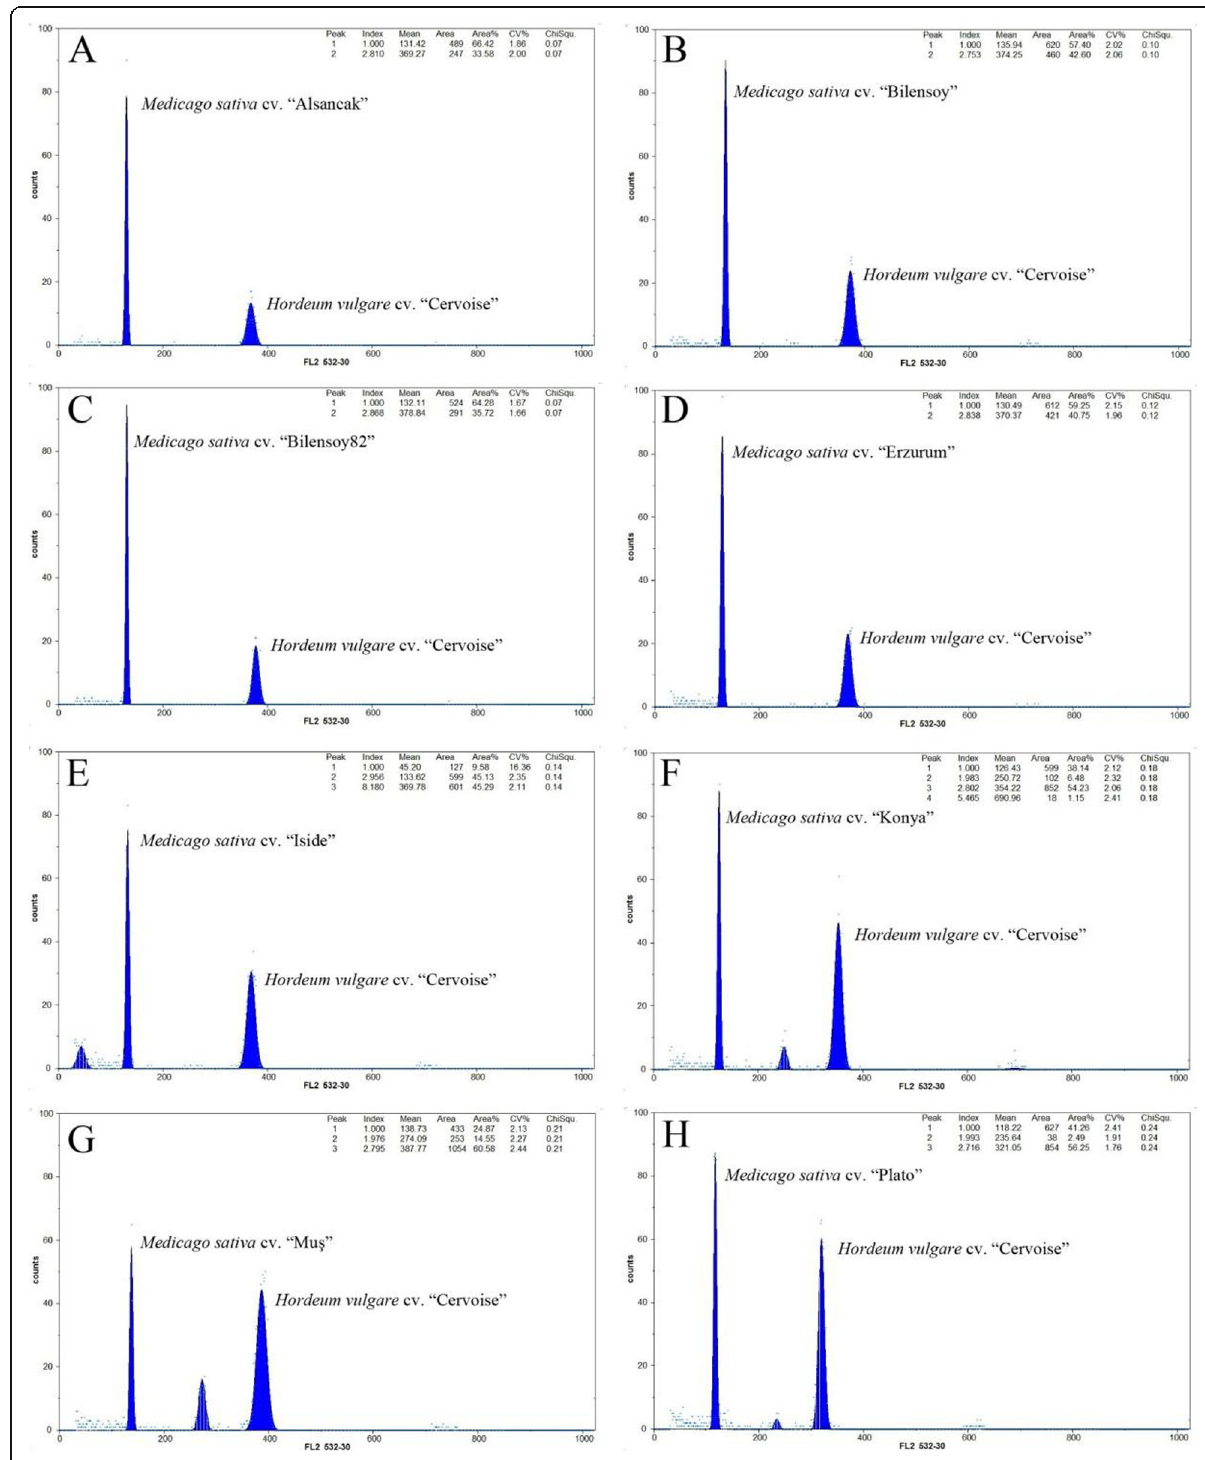
Fig. 2 Flow cytometric analysis of PI stained nuclei alfalfa using Hordeum vulgare “ Cervoise ” as control. a Alsancak , b Bilensoy , c Bilensoy82 , d Erzurum , e Iside , f Konya , g Mu ş , h